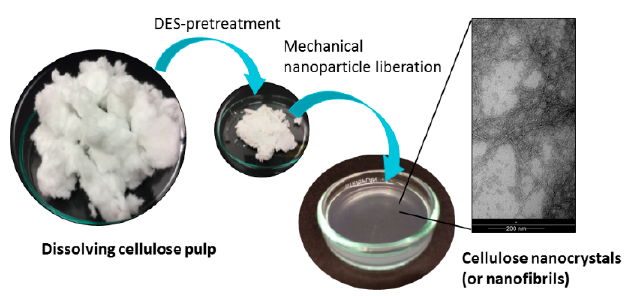
Figure 1. The schematic description of the fabrication stages of nanocellulose samples.